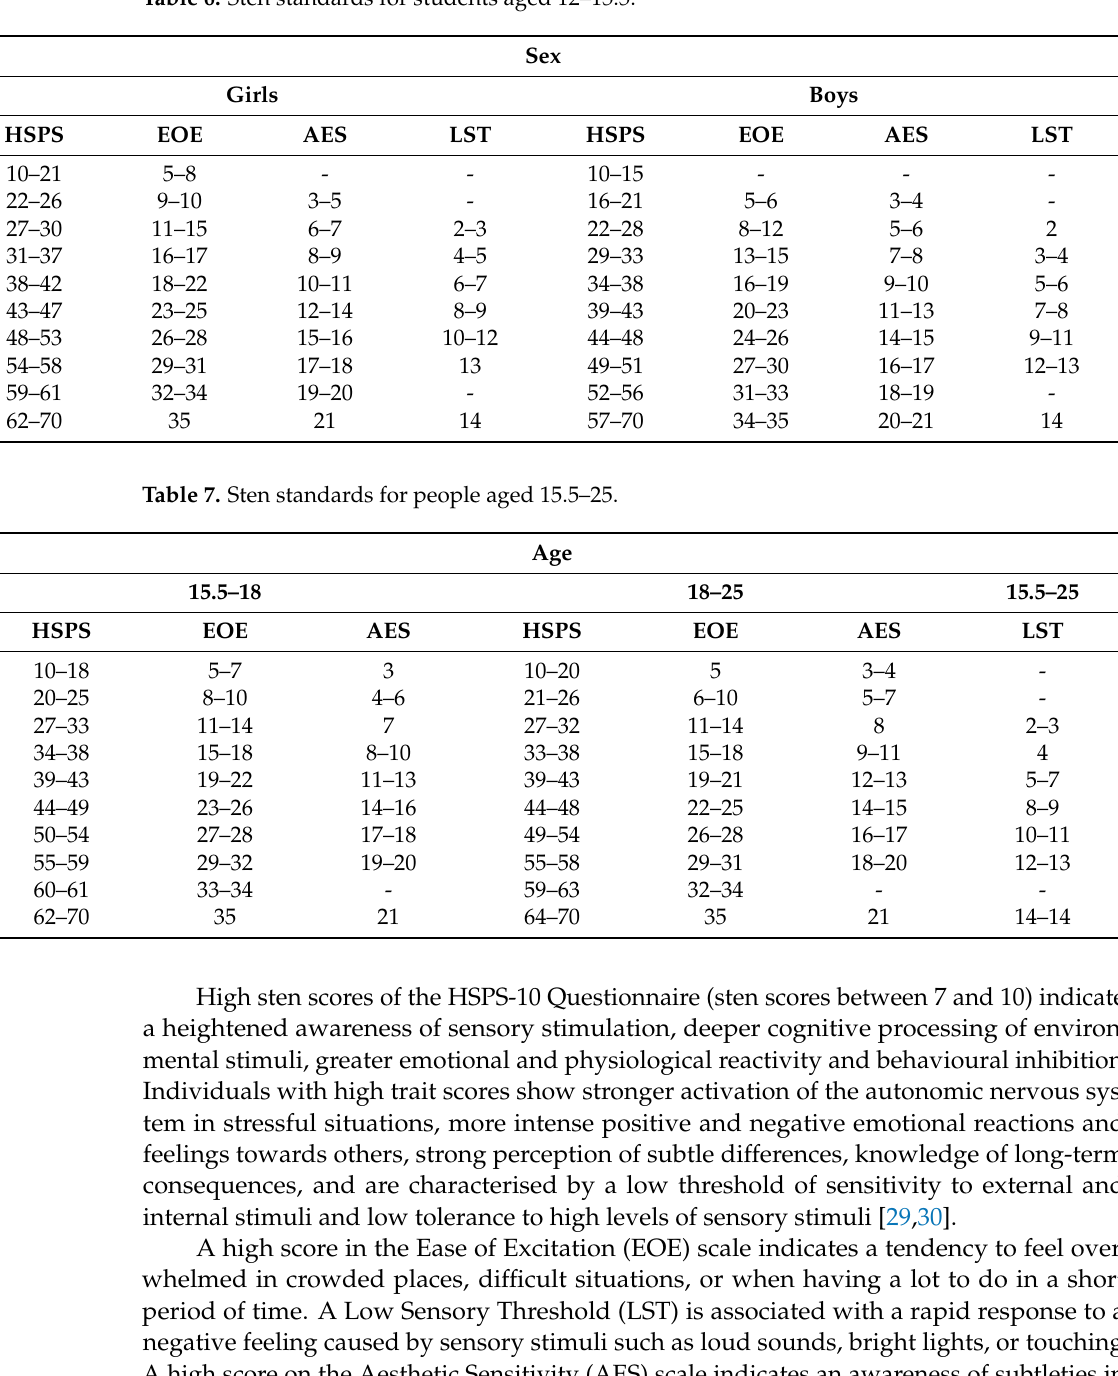
Table 6. Sten standards for students aged 12–15.5.